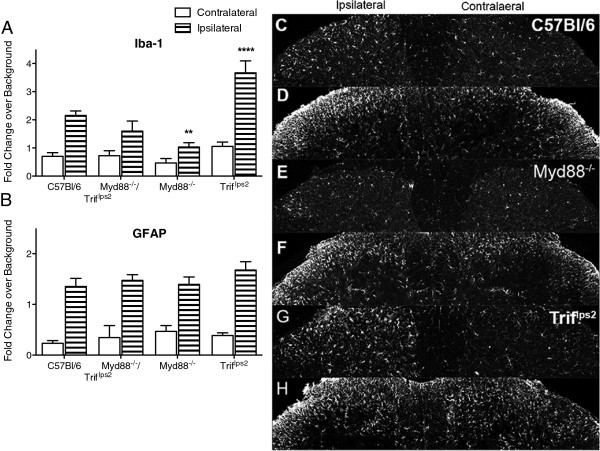
TRIF and MyD88 signaling deficient mice have different Iba-1 immunoreactivity profiles following L5 SNL. At day 14 following L5 SNL the lumbar region of the spinal cord was harvested and incubated with antibodies against Iba-1 and GFAP. Both (A) Iba-1 and (B) GFAP immunoreactivity were consistently significantly elevated in the ipsilateral side of the dorsal horn compared to contralateral within each group. Data expressed as mean ± SEM (n = 3–5 sections per mouse, with 3–4 mice/group) and analyzed via 2-way ANOVA followed by Bonferroni post hoc test. The Iba-1 Triflps2 and Myd88-/- ipsilateral groups are statistically different from the C57BL/6 ipsilateral group (**P <0.01; ****P <0.0001). No significant difference was found among the contralateral groups. Representative stained images are presented from C57BL/6 mice with (C) Iba-1 and (D) GFAP, Myd88-/- mice with (E) Iba-1 and (F) GFAP, and Triflps2 mice with (G) Iba-1 and (H) GFAP, which support the quantified immunoreactivity results.